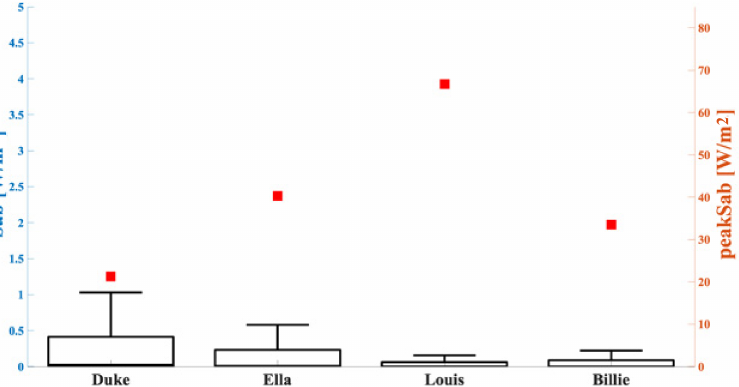
Figure 8. S ab (left y -axis, boxplot) and peak S ab (right y -axis, square symbols) in the tissues included in the cubical box relative to the analyzed simulated human model. The bottom and top edges of the boxes are the 25th and 75th percentiles. The lower whisker extends to the minimum values, while the upper whisker extends to 1.5 times the height of the box.